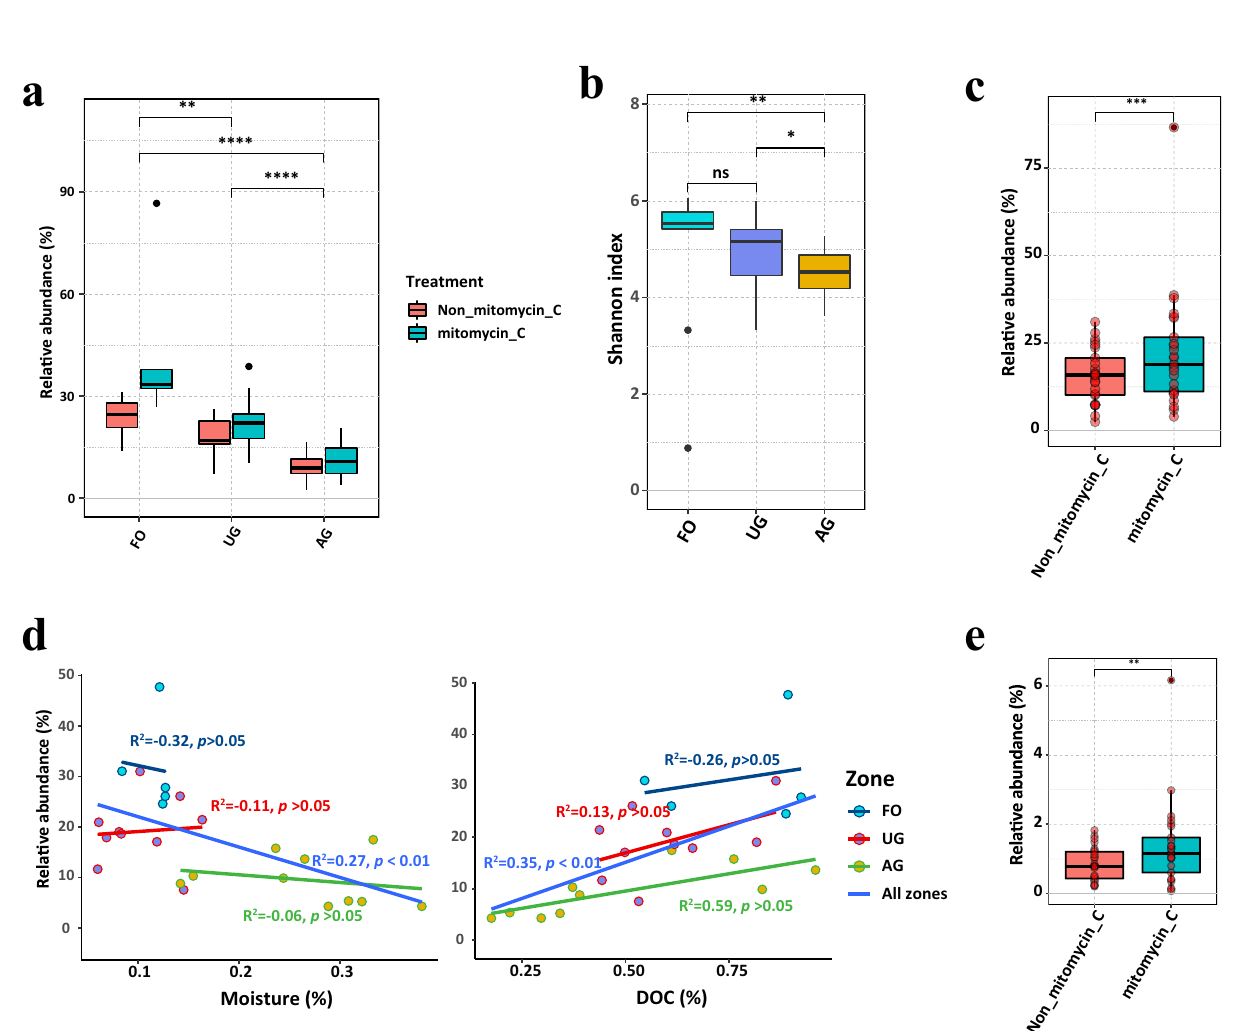
according to their distribution. The “ all zone shared ” as the VCs presented in all zones; “ FO and AG shared ” as the VCs only presented in zone FO and AG, “ UG and AGshared ” astheVCsonlypresentedinzoneUGandAG; “ FOandUGshared ” asthe VCsonlypresentedinzoneFOandUG; “ Unique ” astheVCsexclusivelypresentedin each zone. d The proportion of shared VCs (above) and vOTUs (below) between different zones. e Mantel test showing the correlation between viral communities andgeochemicalparameters.The p valueswereadjusted usingFDR.Thestatistical test used was two-tailed. Source data are provided in the Source Data fi le.